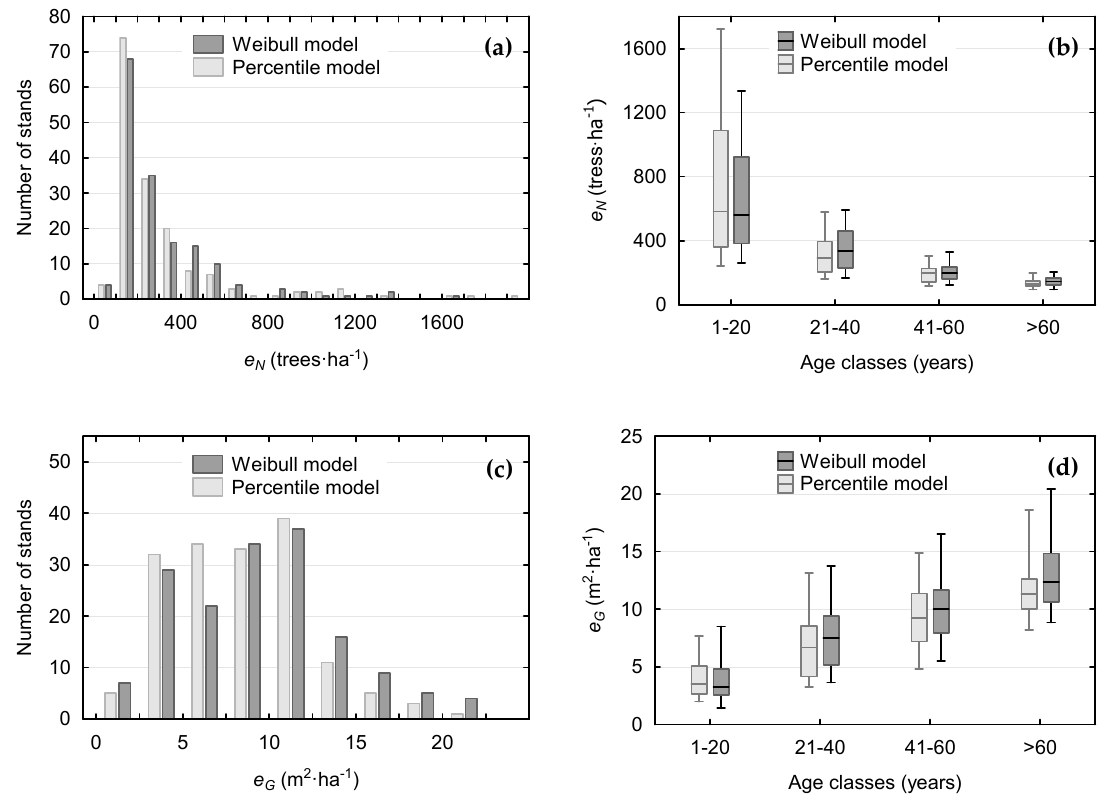
Table 6. Results of the Wilcoxon signed-rank test for comparison of error indexes e N and e G for Weibull and percentile diameter distribution models.